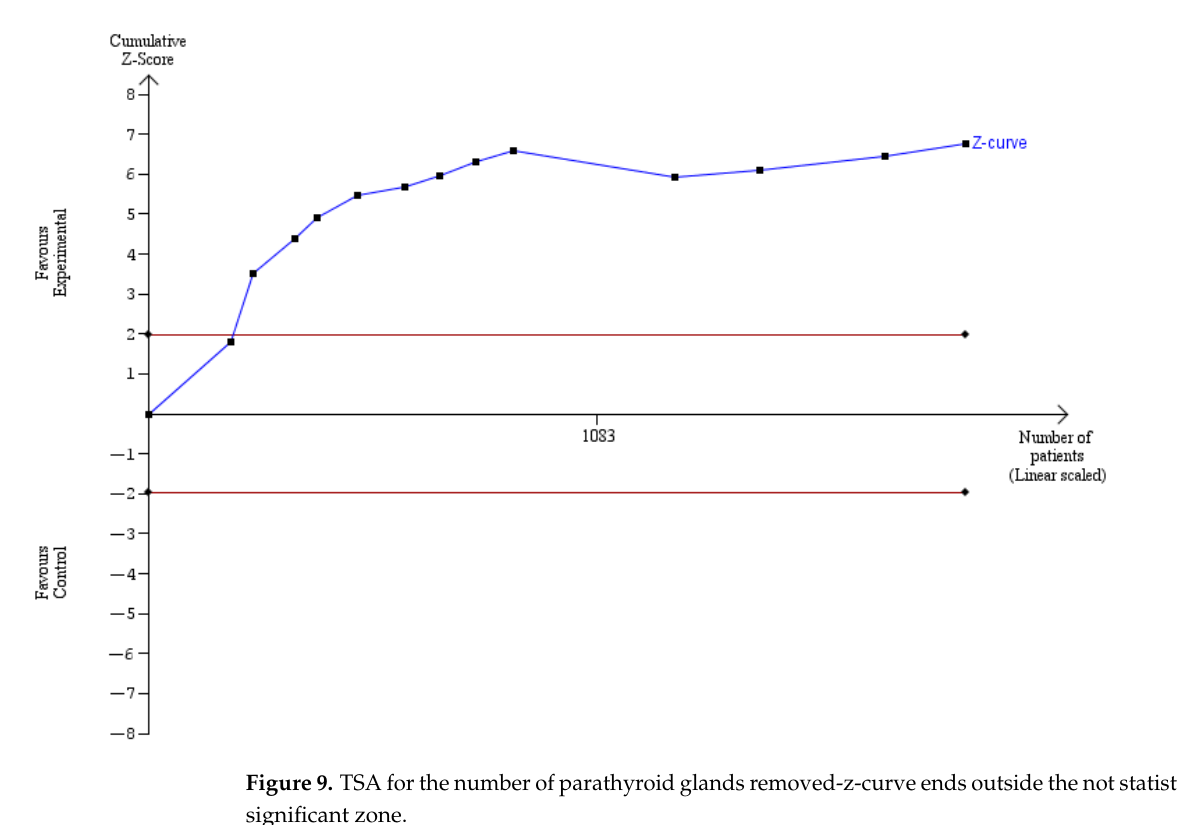
Figure 8. TSA for the number of lymph nodes harvested-z-curve ends outside the not statistically significant zone.